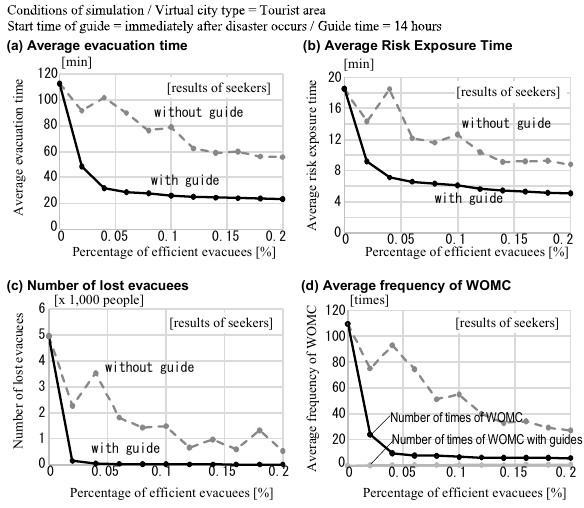
Figure 11. Effects of WOMC with